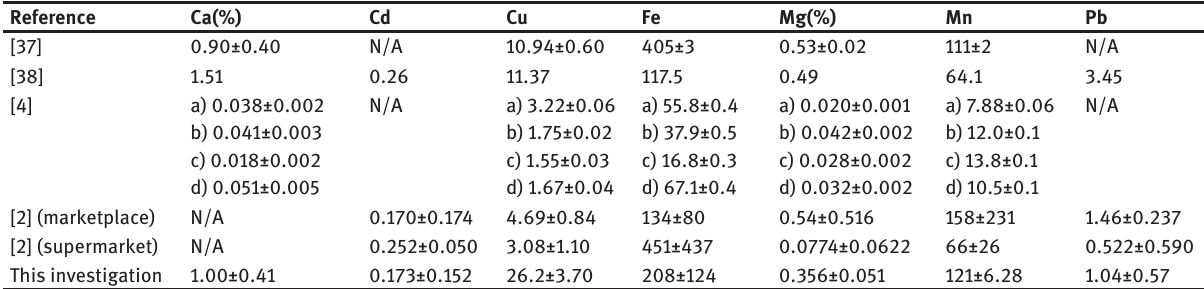
Table 7: Comparison of the previously published results for Croatian, Polish and Serbian tea samples expressed as mg metal per kg of dry plant material